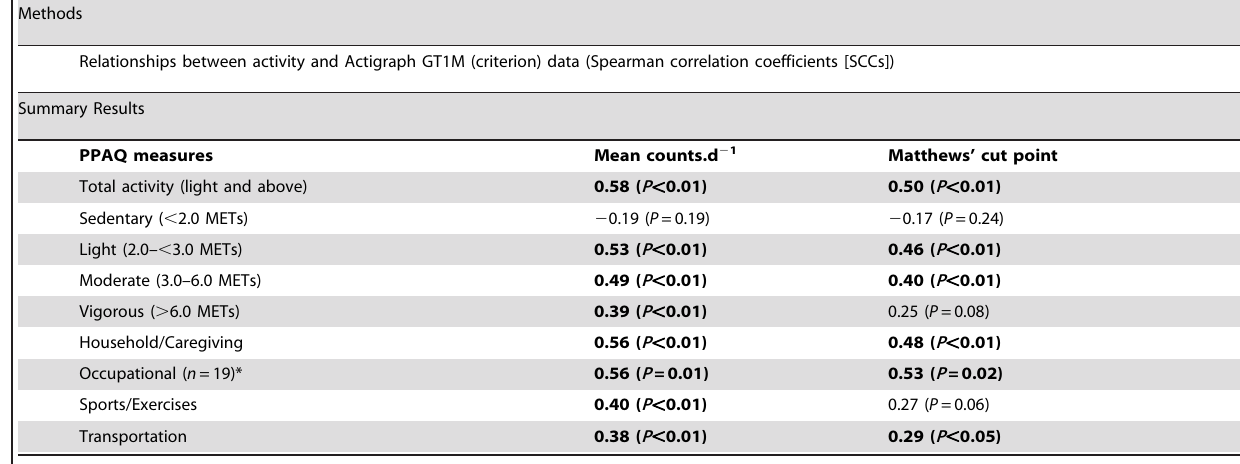
Table 5. Accuracy of the PPAQ.